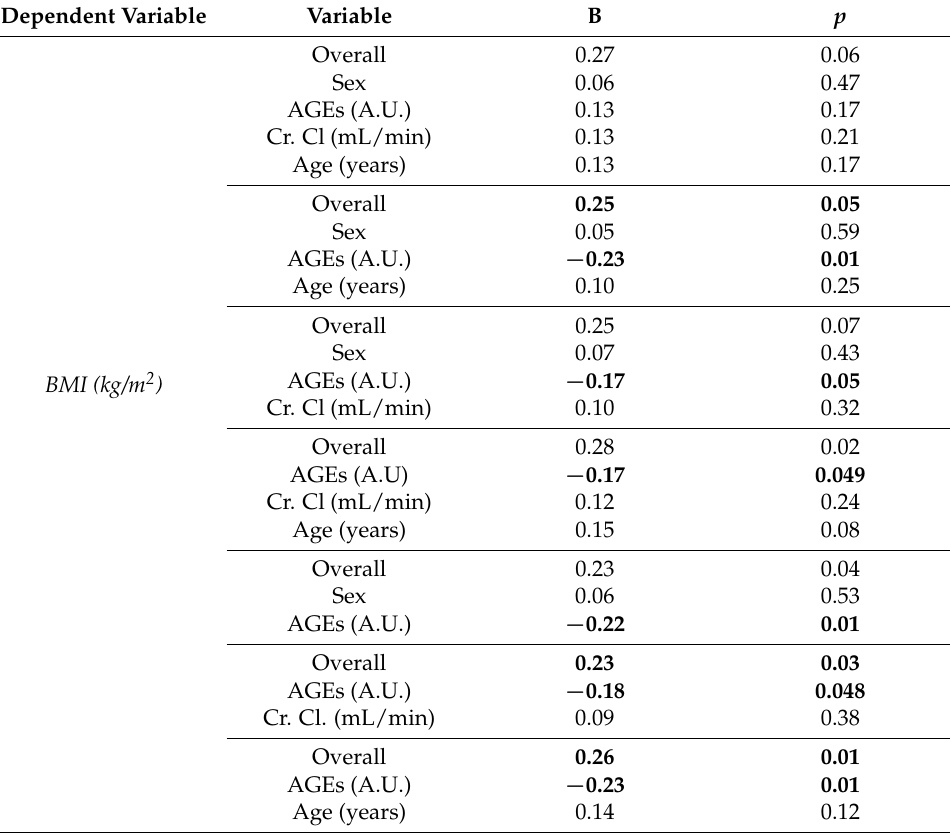
Table 5. Multivariate linear regression analyses testing the association of AGEs with